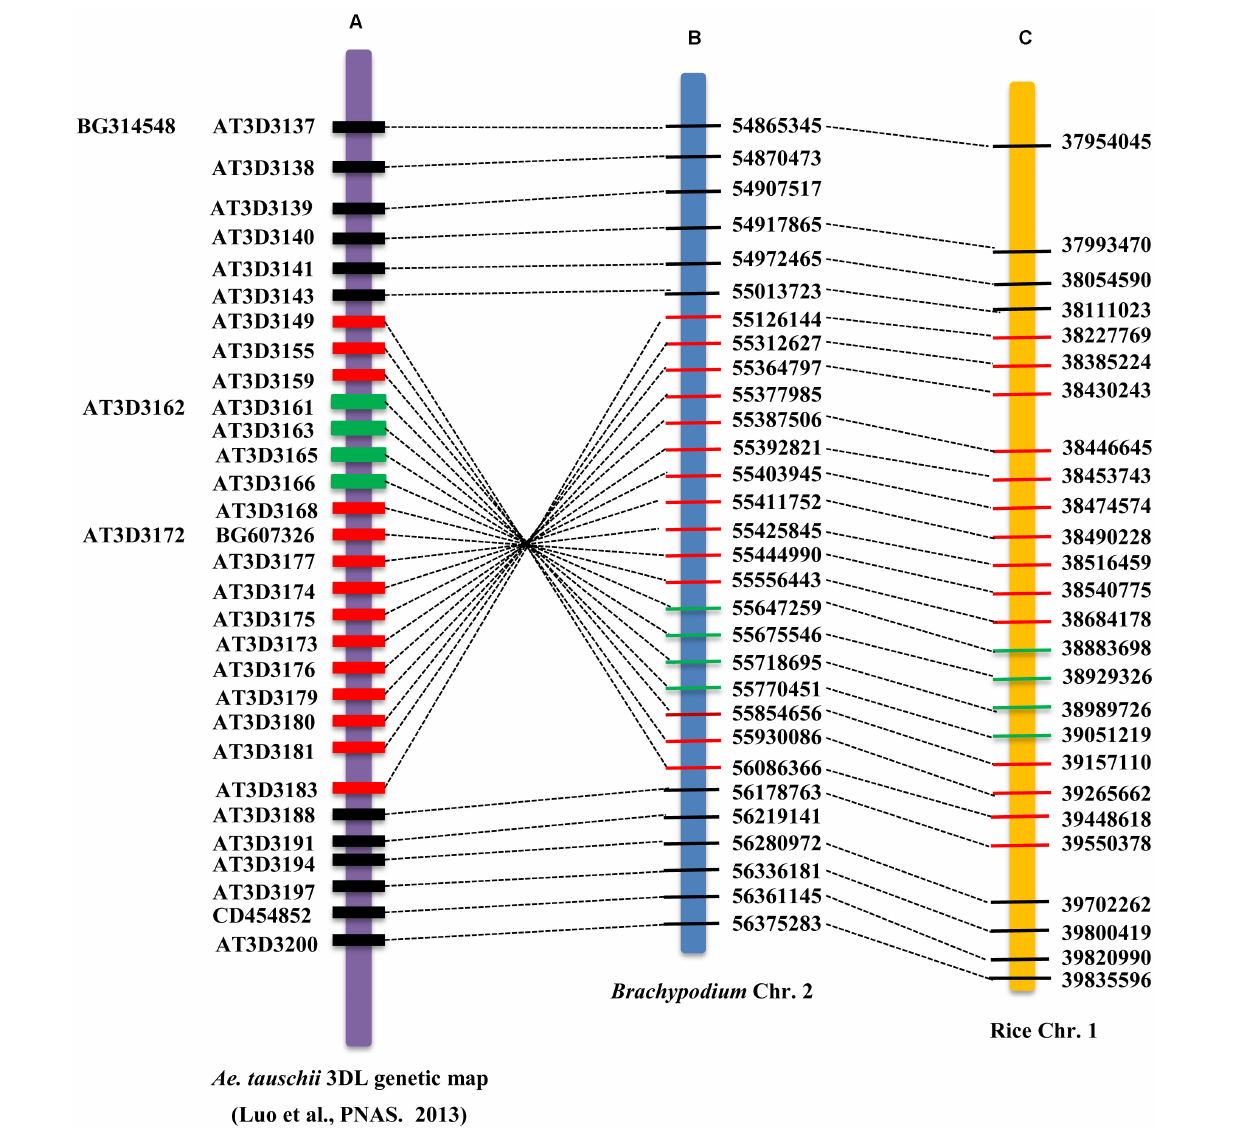
FIGURE 4 | Schematic of the border and position of the genomic inversion around the TaHdm605 locus. The dashed lines indicate the collinear positions of the markers from A. tauschii on Brachypodium chromosome 2 and rice chromosome 1. The red rectangles represent the region of the genomic inversion in A. tauschii , Brachypodium and rice. The green rectangles indicate the region of the TaHdm605 locus covered by the markers M27 and M310 . (A) High-resolution genetic map of TaHdm605 on A. tauschii , with single nucleotide polymorphism (SNP) markers shown on the left. (B,C) Physical maps of TaHdm605 on Brachypodium chromosome 2 and rice chromosome 1, with physical position on the